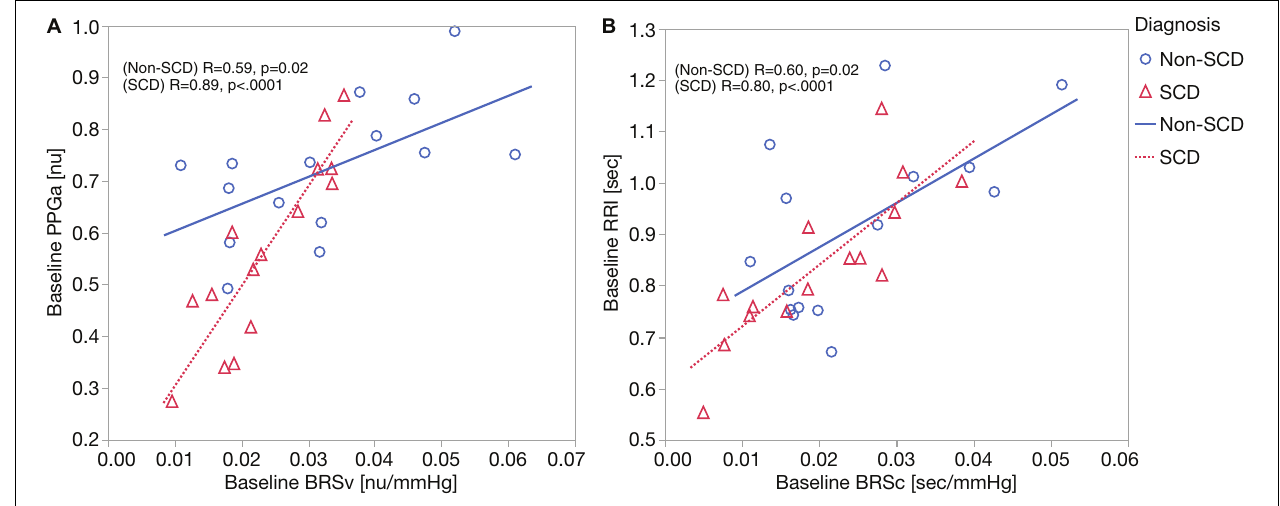
FIGURE 2 | (A) Correlation analyses between baseline BRSv and (cid:49) PPGa: the relationship between baseline BRSv and (cid:49) PPGa is stronger in SCD subjects ( p = 0.0005). (B) Correlation analyses between baseline BRSc and (cid:49) RRI. No interaction was observed between baseline BRSc and diagnosis.